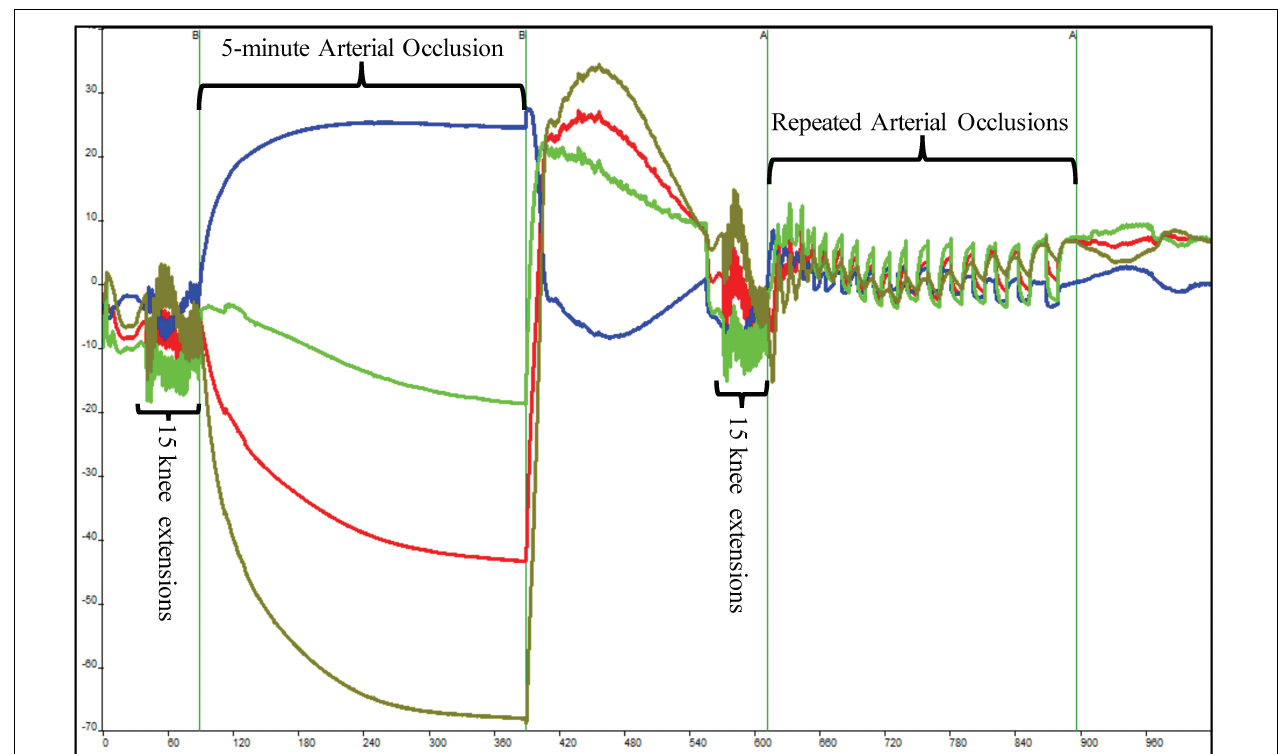
FIGURE 2 | Depiction of raw near-infrared spectroscopy (NIRS) data during a single muscle oxidative capacity (MOC) test. Fifteen IK knee extensions were used to increase skeletal muscle metabolic rate that was followed by a 5-min occlusion induced by a high-pressure cuff. Following a 3-min recovery period, another set of 15 IK knee extensions followed by a series of short arterial occlusions were performed. The blue line indicates deoxyhemoglobin (HHb), red indicates oxyhemoglobin, olive line indicates hemoglobin difference, and green line depicts total hemoglobin.